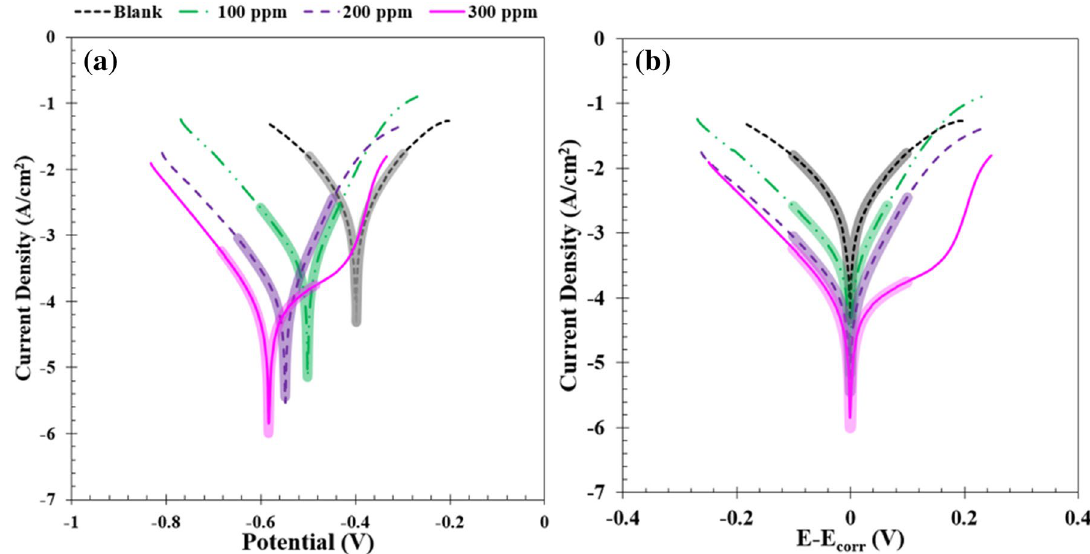
Figure 5. Polarization plot of the MS specimens dipped in HCl solution containing different concentrations of GSE at 25 °C: as recorded ( a ) and shifted to E corr = 0 V ( b ). Pale-colored curves are fitting curves according to the Wagner–Traud